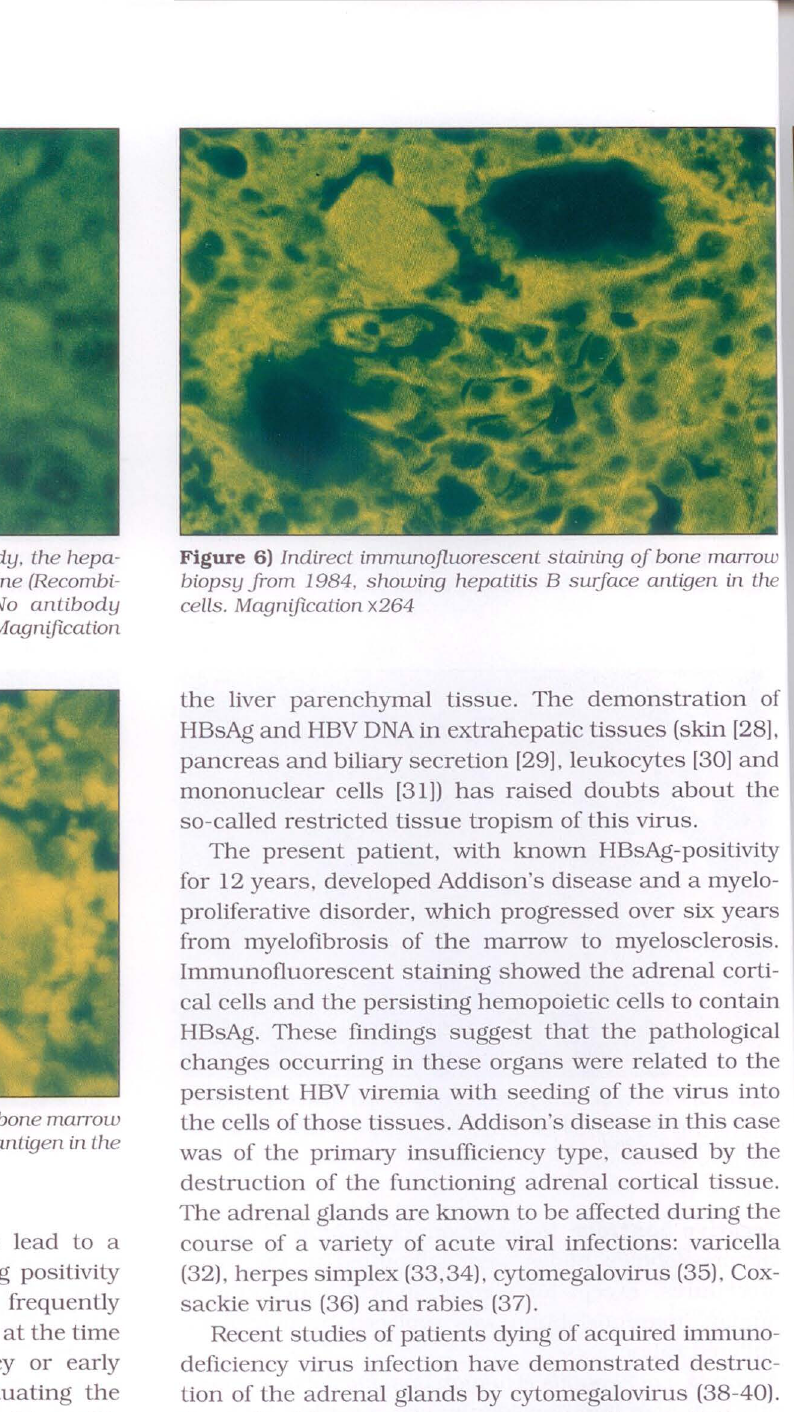
Figure 7) Indirect immunofluorescent staining of a bone marrow biopsy, showing attachment of hepatitis B surface antigen in the cells. Magn!fication x264